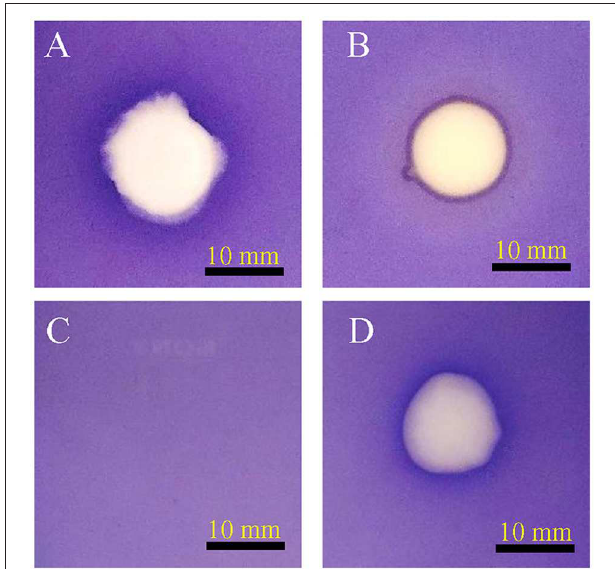
FIGURE 1 | Anti-quorum sensing activity of isolate SJ01. The biosensor plates containing reference strain C. violaceum CV026 were spotted with (A) cinnamaldehyde, (B) SJ01 axenic culture, (C) methanol, and (D) crude bacterial (SJ01) extract. Cinnamaldehyde was used as a positive control. The isolate SJ01 and its extract showed the anti-quorum sensing activity and a clear white opaque zone of inhibition.